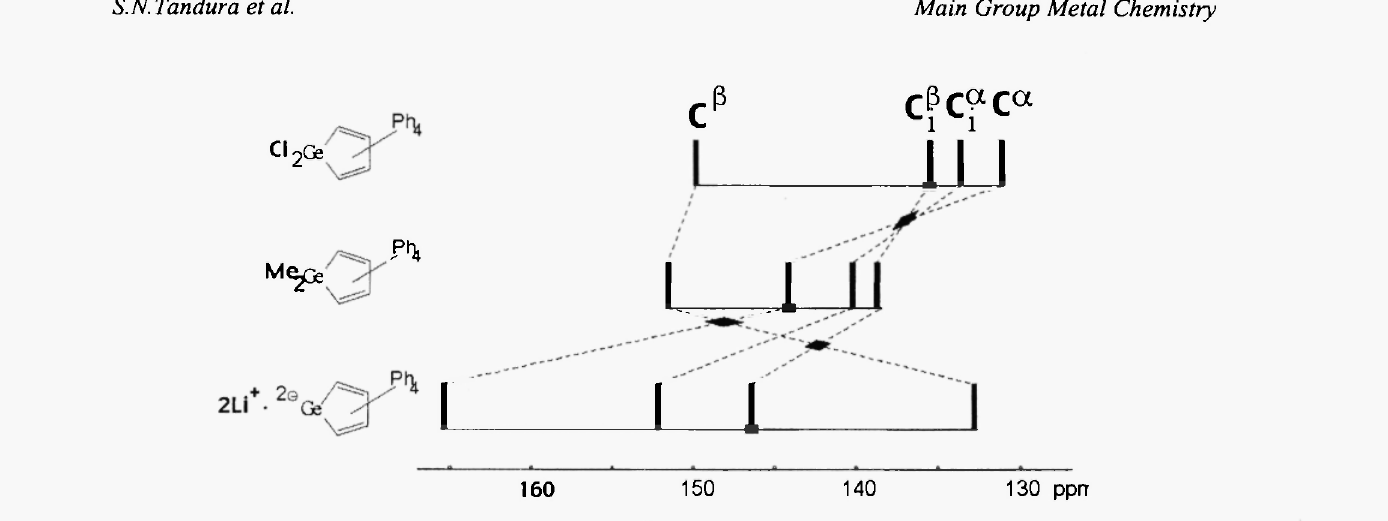
Figure 1. Schematic diagram showing the 13 C chemical shifts of the quaternary carbon atom resonances in germoles II (in CDC1 ) and in the dianion lb (in THF). 3 The 13 C chemical shifts in conjugated systems depend inversely on the π-electron density on the carbon atoms [17], Typically, considerable upfield shifts in 13 C NMR spectra are observed for carbon atoms of the five-membered negatively charged cycles having aromatic character (e.g., cyclopentadienyl anion) relative to those in the corresponding uncharged analogs [18,19], For example, the difference between Z(5(C a ) + 5(C ß )) in 1,2,3,4- tetraplienylcyclopentadiene'monoanion and its uncharged analogs is -31 ppm [19], In the case of dichlorogermole (dimethylgermole) Π and the germole dianion lb the values of Z(6(C a ) + 5(C P )) differs very little: 283 ppm for Π (R 1 = R 2 = CI), 295 ppm for Π (R 1 = R = Me) and 298 ppm in the dianion